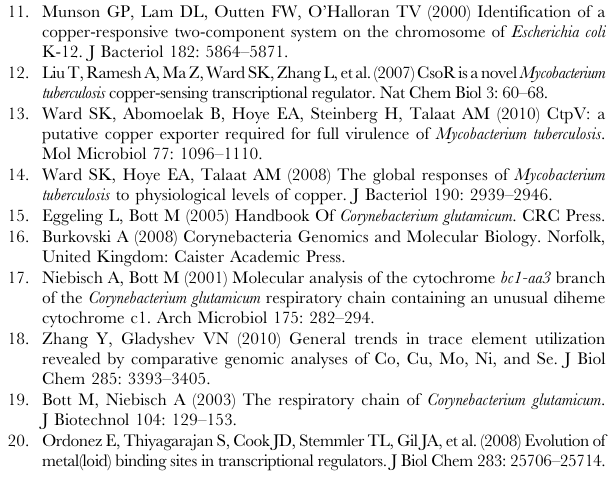
Table S1 Oligonucleotides used in this